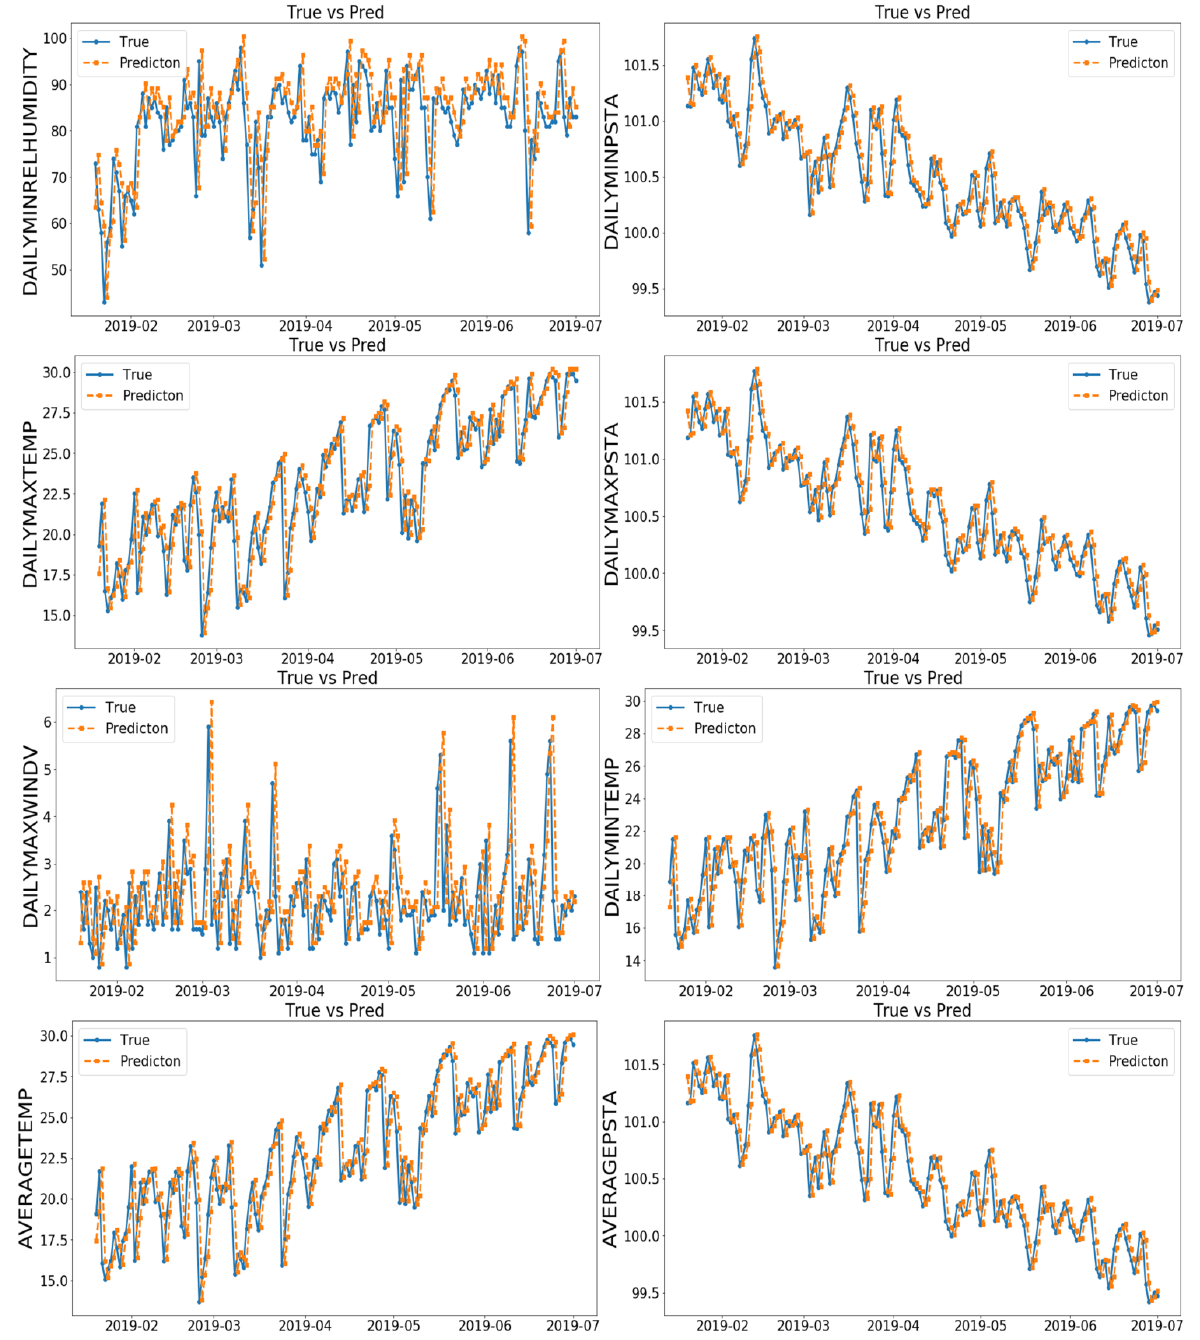
Figure 6. The predicted values and the actual value